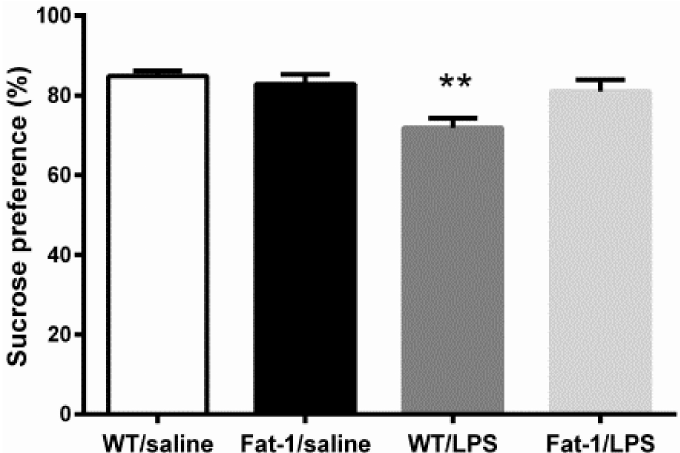
Figure 2. LPS decreased sucrose preference in wild-type mice, which was not reversed in Fat-1 mice. ** p < 0.01 vs. WT/saline. LPS: lipopolysaccharides; WT: